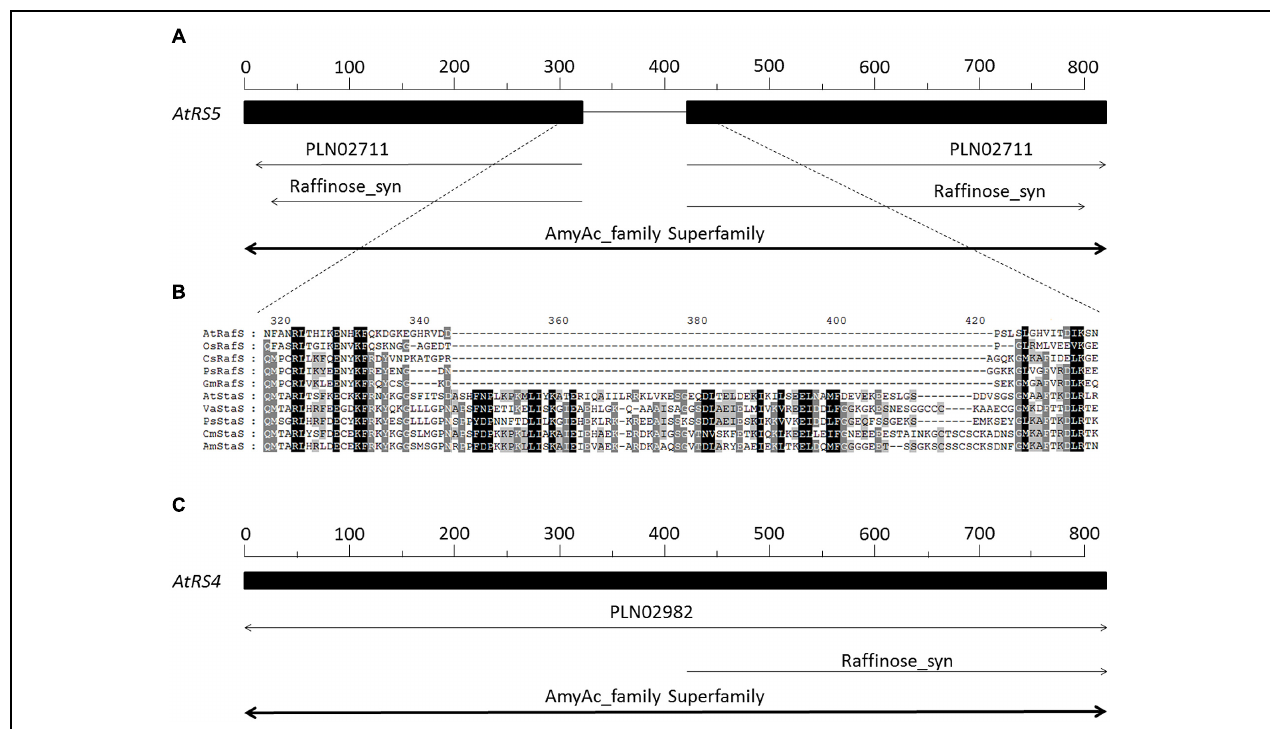
FIGURE 2 | Sequence and phylogenetic analysis of AtRS4 and AtRS5 . (A) Schematically shows the 783 amino acid long sequence of AtRS5 (A5g40390) from Arabidopsis thaliana . (B) Shows a section of a sequence alignment performed with Clustal Omega (Sievers et al., 2011) of RafS and StaS amino acid sequences, which revealed very high amino acid identity and similarity, except for a 80 amino acid long sequence block insertion, which is only present in the StaS. (C) Schematically shows the 876 amino acid long sequence of AtRS4 (At4g01970) from A. thaliana. RafS amino acid sequence from A. thaliana (AtRafS, gi|332195171), Oryza sativa subsp japonica (OsRafS, gi|115471135), Cucumis sativus (CsRafS, gi|124057819), Pisum sativum (PsRafS, gi|18181865) and Glycine max (GmRafS, gi|187610414). StaS amino acid sequence from A. thaliana (AtStaS, gi|332656706), Vigna angularis (VaStaS, gi|6634701), P. sativum (PsStaS, gi|13992585), Cucumis melo (CmStaS, gi|659101177) and Alonsoa meridionalis (AmStaS,